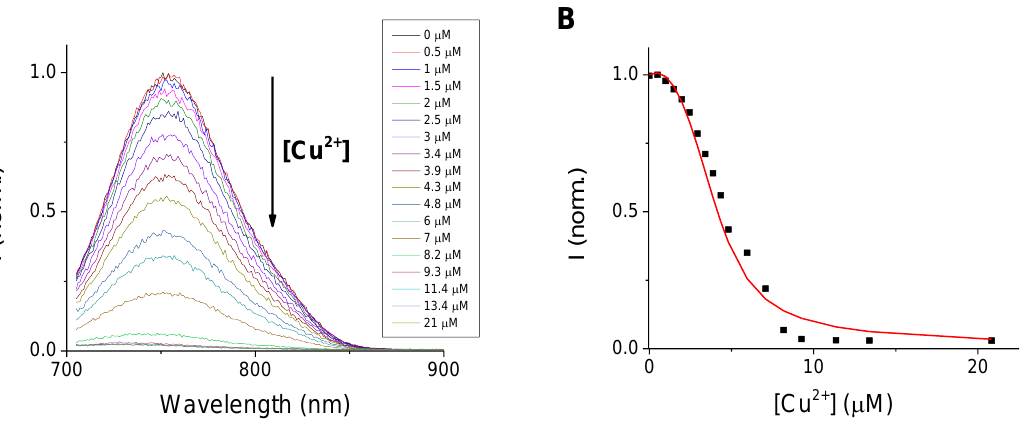
Figure 6. ( A ) Emission spectra and ( B ) corresponding changes in the total emission of 1 (5 µM), in the presence of increasing amounts of Zn 2+ . Conditions: MeOH:MOPS 10 mM pH7 (50:50); λ exc = 620 nm.